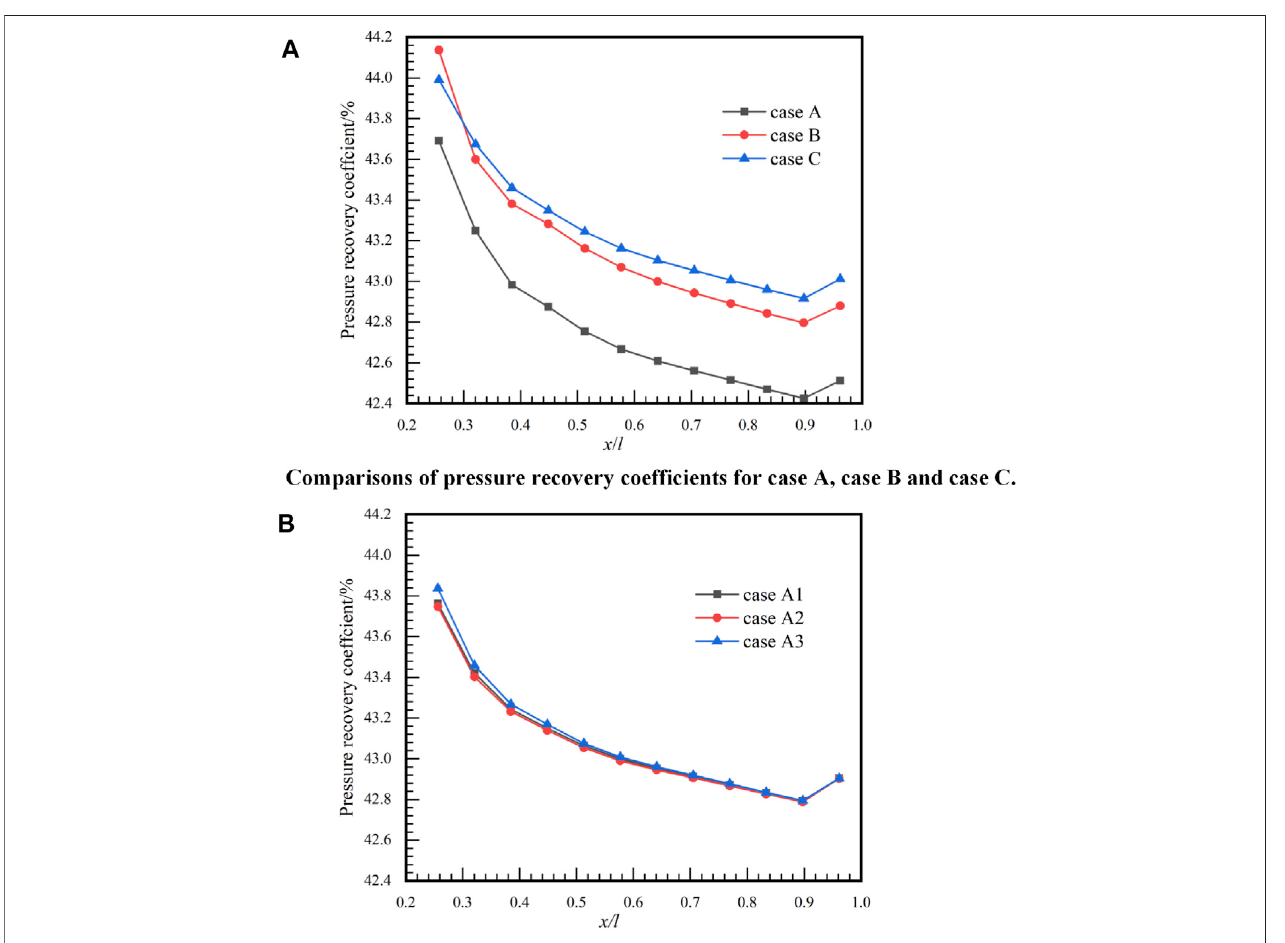
FIGURE 13 | Pressure recovery coef fi cients distributions for all cases: (A) pressure recovery coef fi cients of different cases of the head shapes; (B) pressure recovery coef fi cients of different cases of the exhaust inlet patterns.